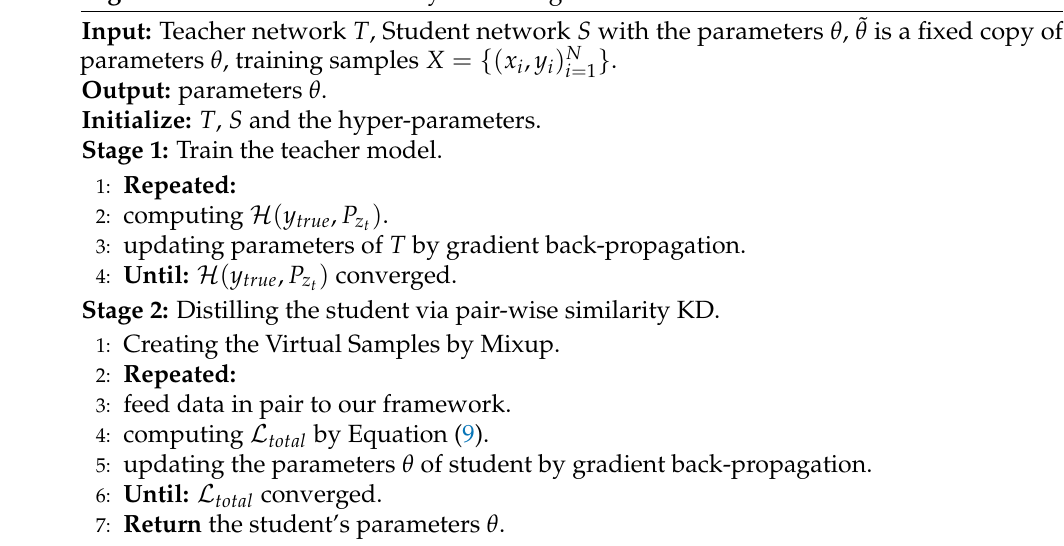
Algorithm 1 Pair-wise Similarity Knowledge